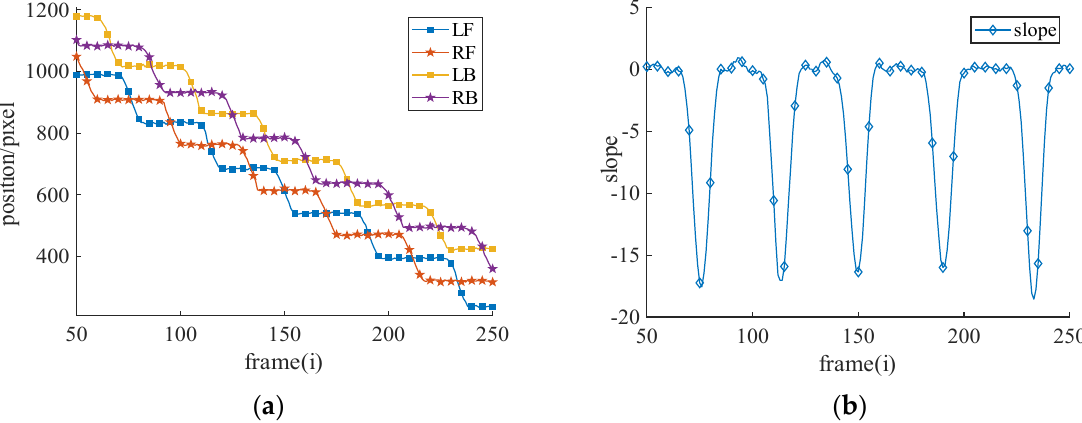
Figure 13. ( a ) Buffalo’s feet displacement curve; ( b ) first−order differential curve of buffalo’s feet displacement.